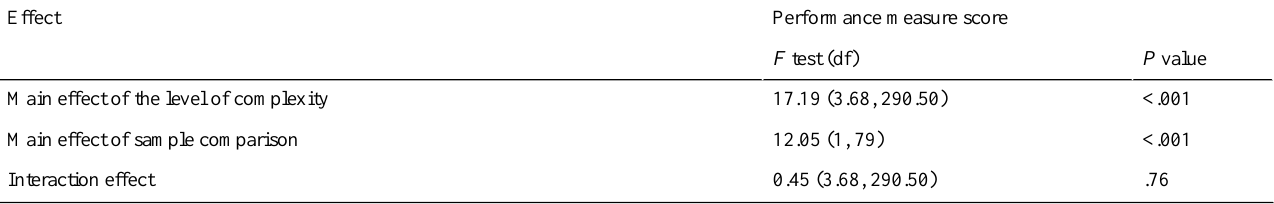
Table 5. Inferential statistics for research question 1.